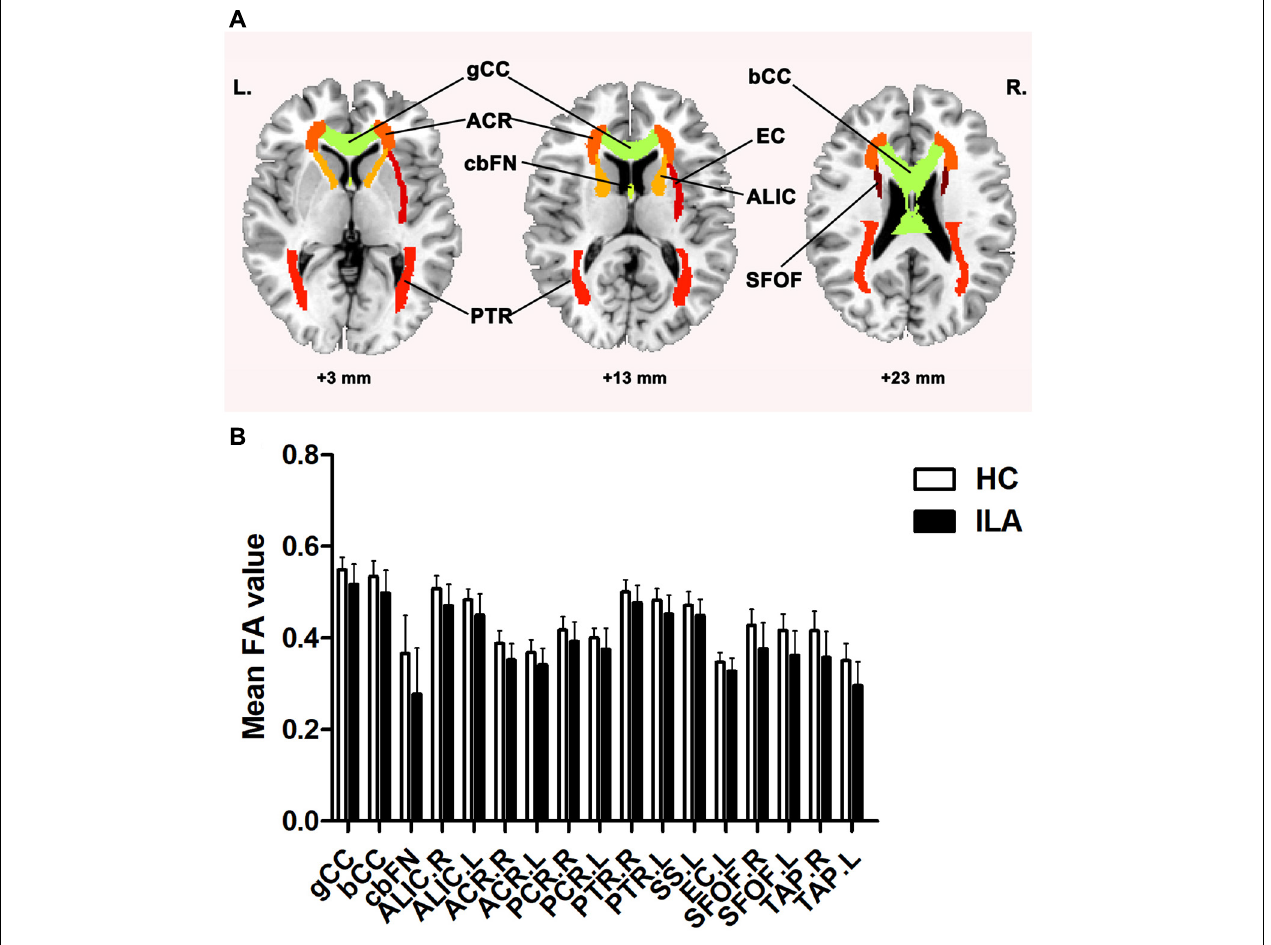
FIGURE 1 | (A) ILA-related disruption in WM tracts. (B) Compared with HCs, the ILA group displayed significantly lower FA in widespread atlas-based tract ROIs after FDR correction. For the abbreviations of WM tracts, see Supplementary Table 1 . HC, healthy controls; ILA, ischemic leukoaraiosis; FA, fractional anisotropy. L, left; R,